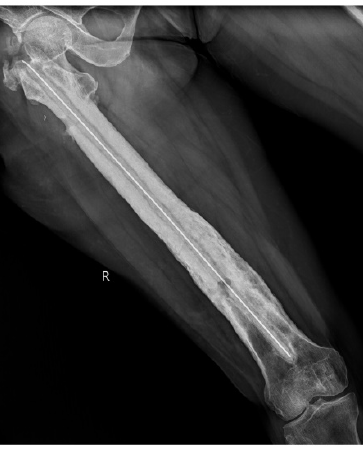
Figure 9. Post operative radiograph with subcutaneous placement of SPHCS beads